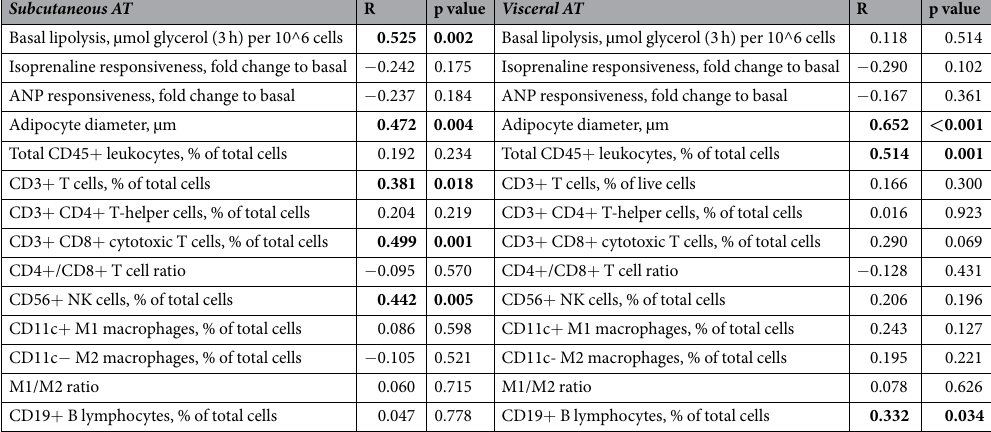
Table 3. Pearson correlation coefficients between AT lipolysis, AT size and AT immunophenotype of subcutaneous and visceral AT depots and whole-body IR. ANP, atrial natriuretic peptide; AT, adipose tissue; NK, natural killer; CD, cluster of